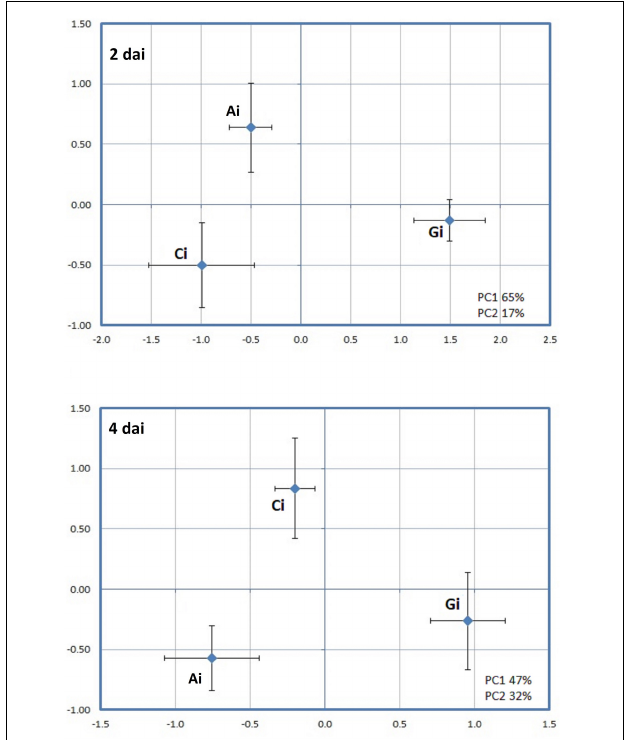
FIGURE 6 | Principal component analysis (PCA) performed for the spots whose volume significantly changed in abundance ( p -value < 0.05) between PRI treatments followed by H. vastatrix infection, at 2 and 4 days after inoculation (i): Greenforce CuCa (Gi), ASM (Ai), and Control (Ci).